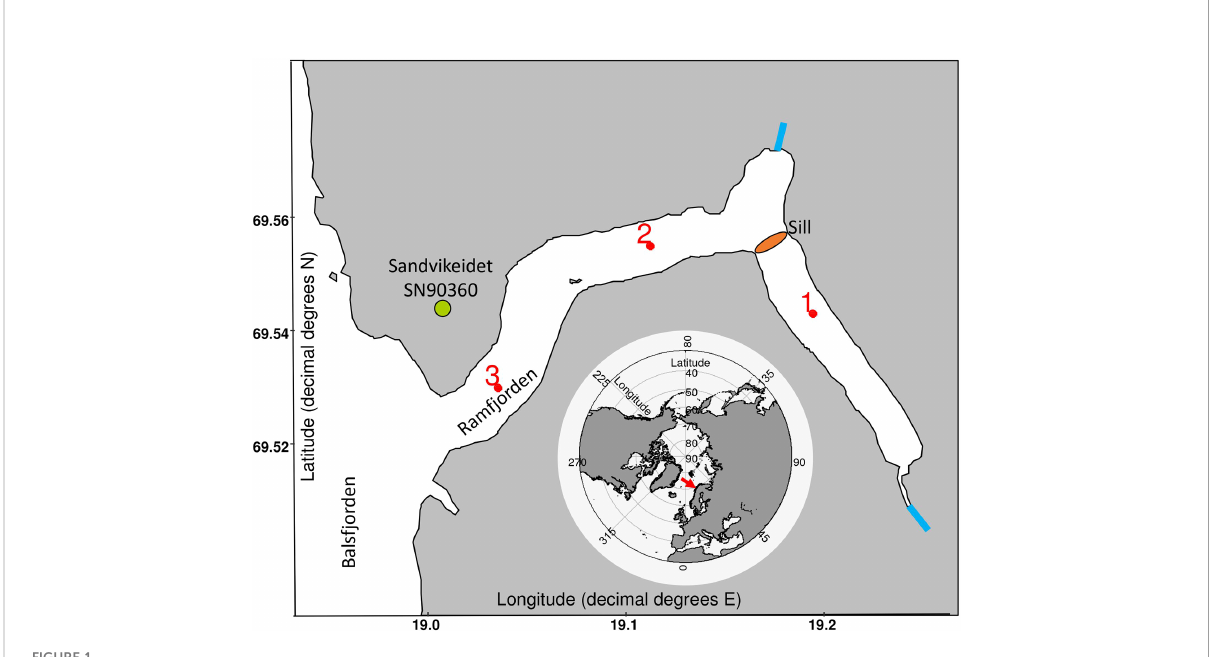
FIGURE 1 Sampling locations in Ramfjorden. The red numbers and dots show the location of the sampling stations, and the blue lines indicate the two major river inputs. The position of Ramfjorden is indicated by the red arrow on the pan-Arctic map. The shape fi les were retrieved from www. kartverket.no (2020). The sill in Ramfjorden is indicated by the brown ellipse, the meteorological station at Sandvikeidet as a green circle. The meteorological station in Tromsø is ca 14 km northwest of station